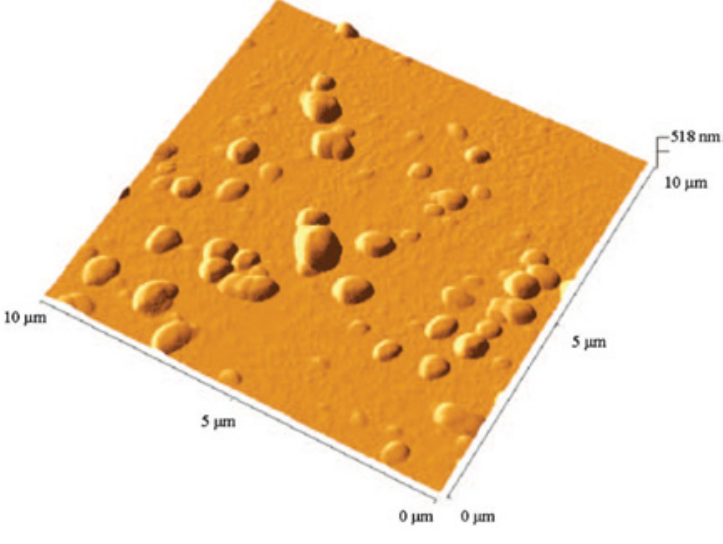
Figure 33. Non-contact mode AFM image of 19 -based nanoparticles